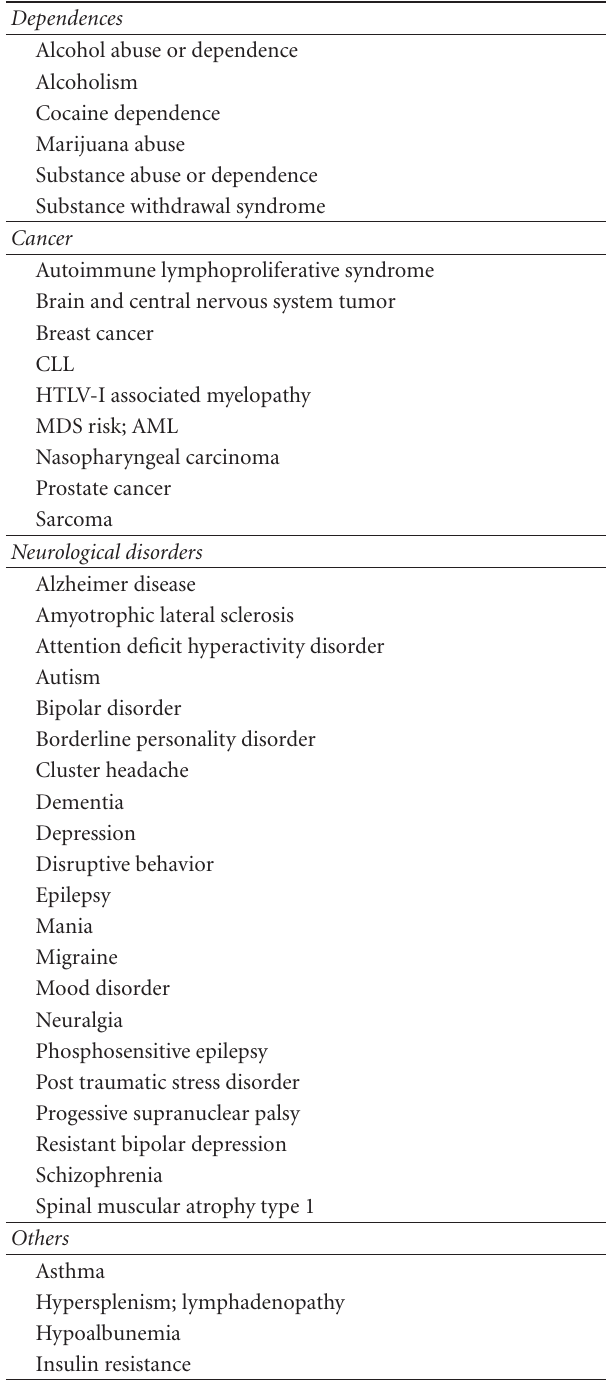
Table 1: Ongoing clinical studies implicating valproic acid in